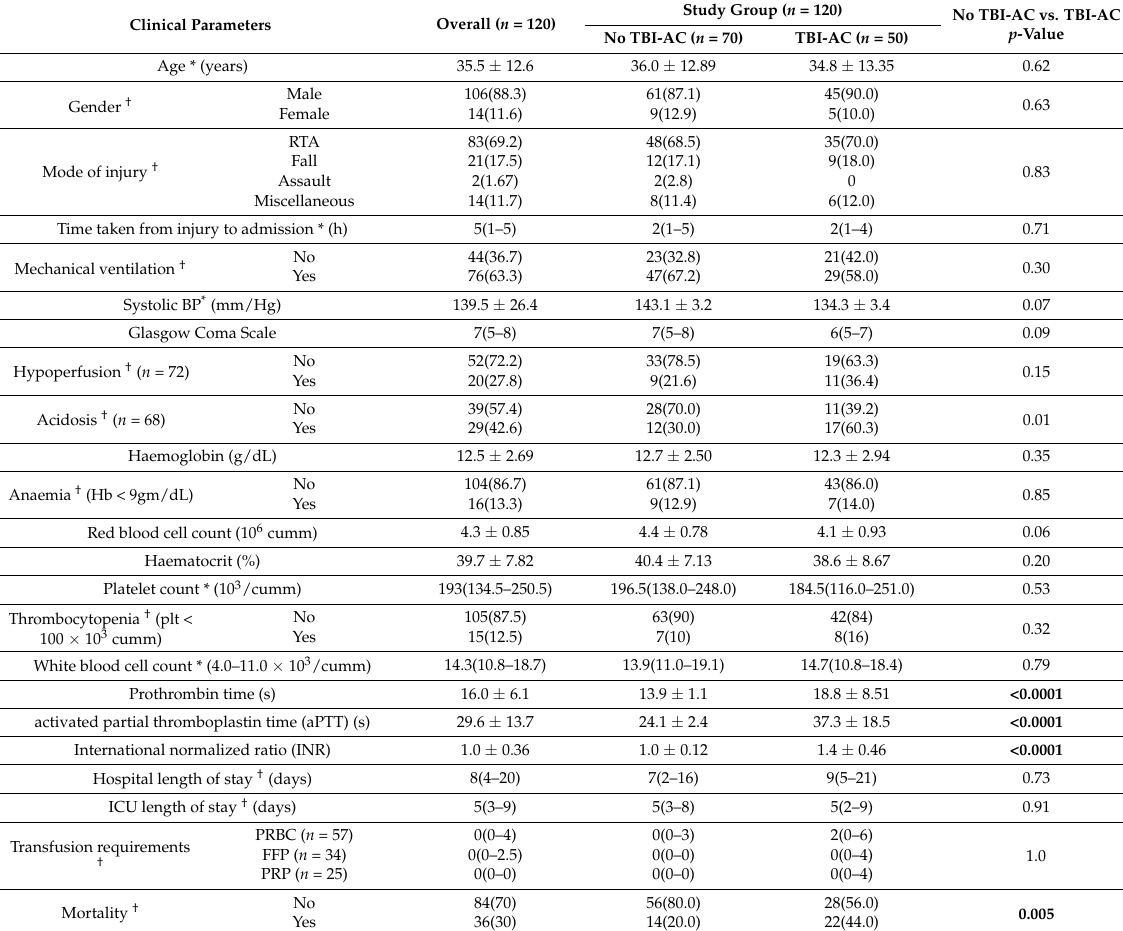
Table 1. Demographic and clinical pattern of the study cohort overall and as stratified by the presence of traumatic brain injury-associated coagulopathy (TBI-AC). Clinical